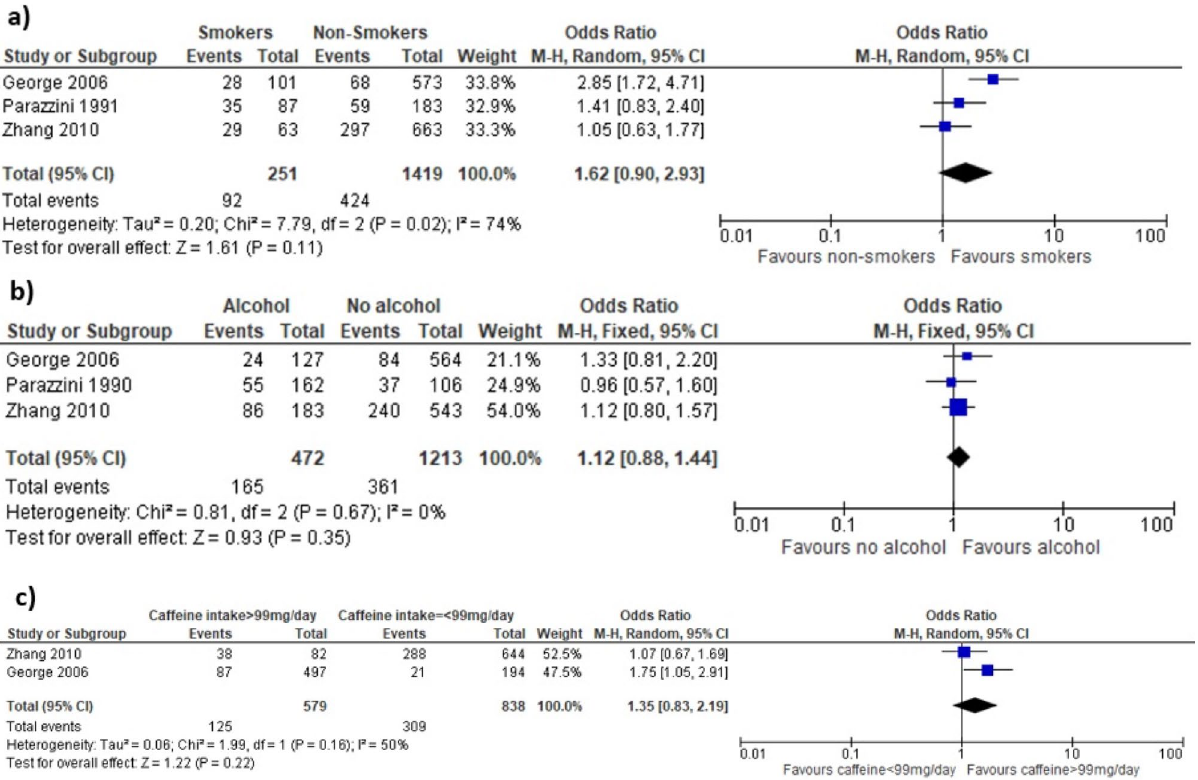
Figure 3. Forest plot demonstrating meta-analysis of the effect of lifestyle factors on RPL. ( a ) Cigarette smoking does not significantly increase risk of RPL in general population. ( b ) Alcohol intake does not significantly increase risk of RPL in general population. ( c ) Caffeine intake does not significantly increase risk of RPL in general population. 95% CI = 95% confidence interval; M-H = Mantel–Haenszel statistical